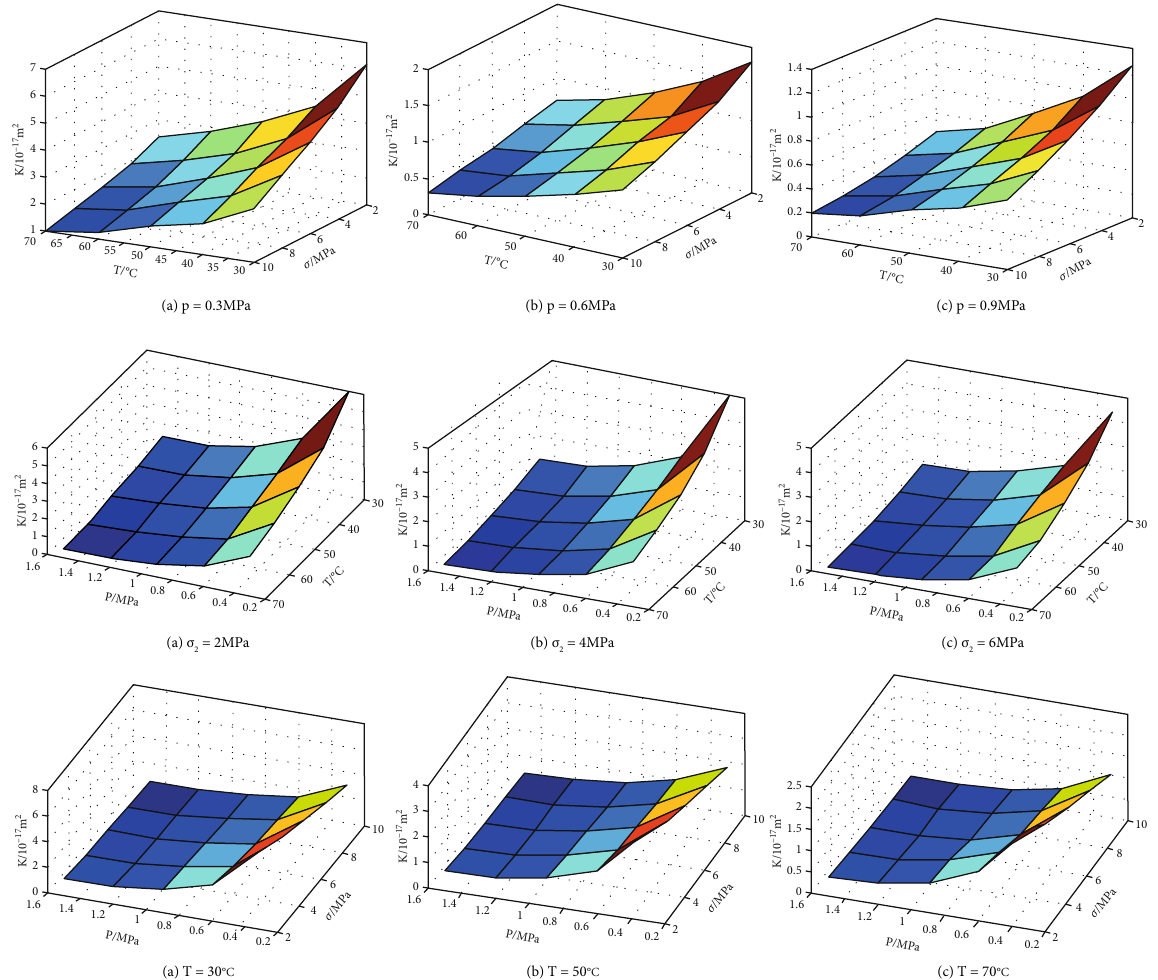
Figure 5: The permeability surface of coal body. (a) k - T -surface graphs of coal samples. (b) k - p- surface graphs of coal samples. (c) k - p -surface graphs of coal